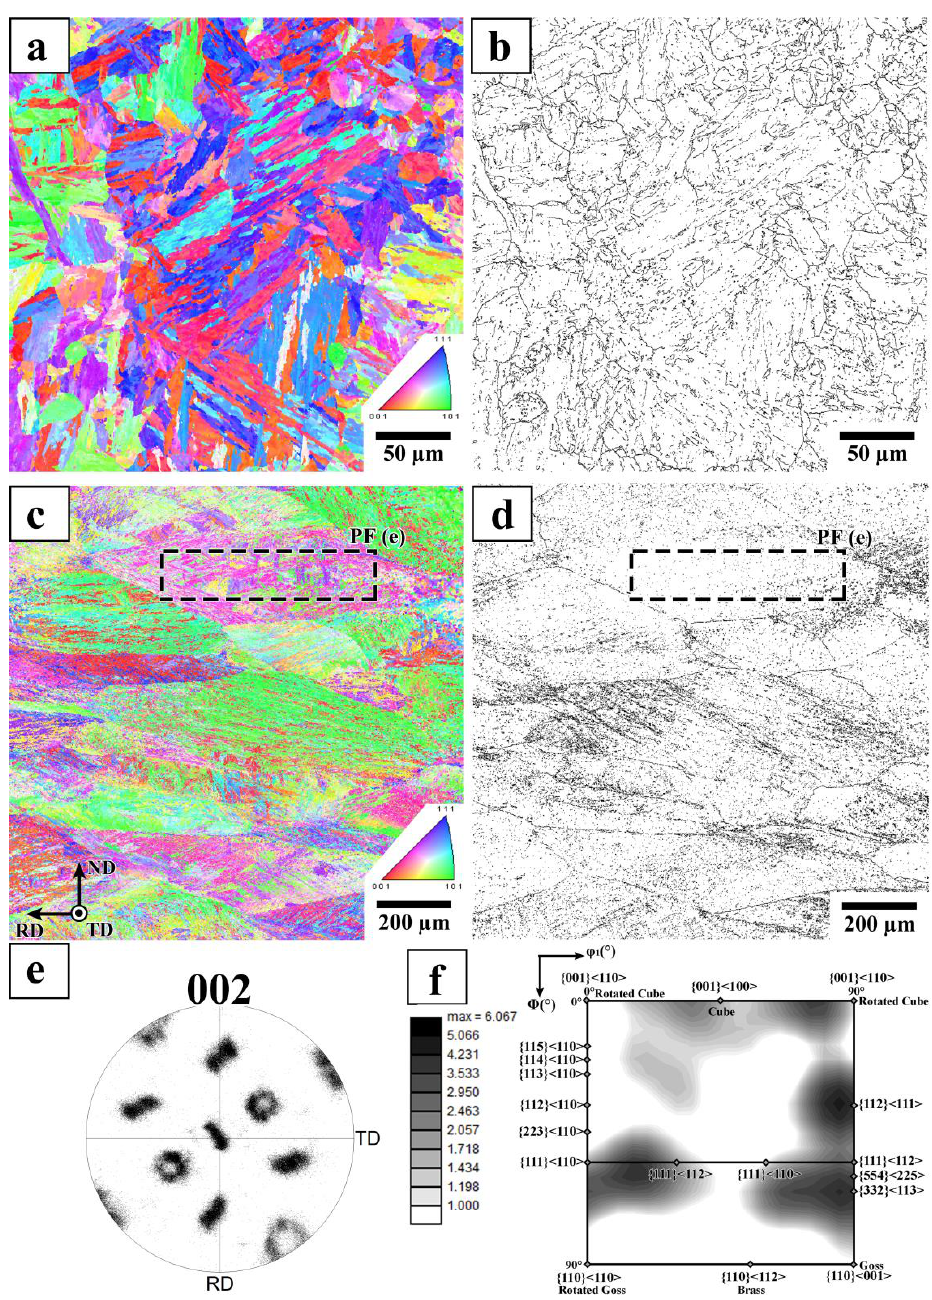
Figure 4. EBSD analysis of the untempered NT ( a , b ) and HR+Q ( c – f ) samples. Inverse pole figure maps for TD ( a , c ) and grain boundary maps showing the boundaries with misorientations between 20° and 49° to reveal PAGs ( b , d ). The <002> pole figure ( e ) and ODF (φ 2 = 45° section) of the HR+Q sample ( f ).